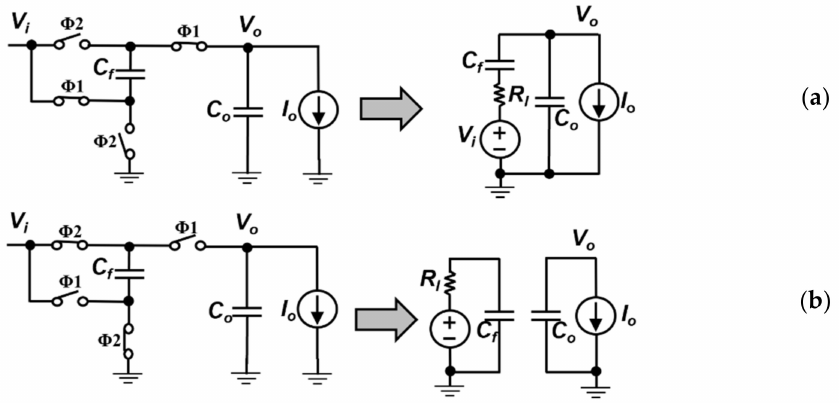
Figure 1. Two-phase switching operation of 1-stage linear charge pump ( a ) Φ 1 = 1; Φ 2 = 0 ( b ) Φ 1 = 0; Φ 2 = 1.